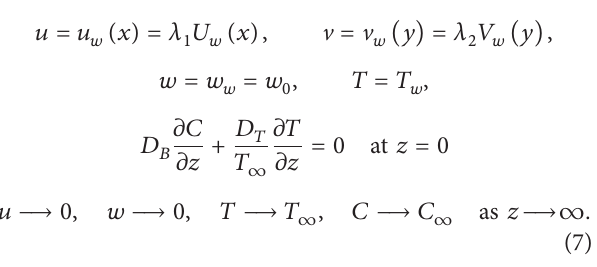
Figure 1: Geometry of the